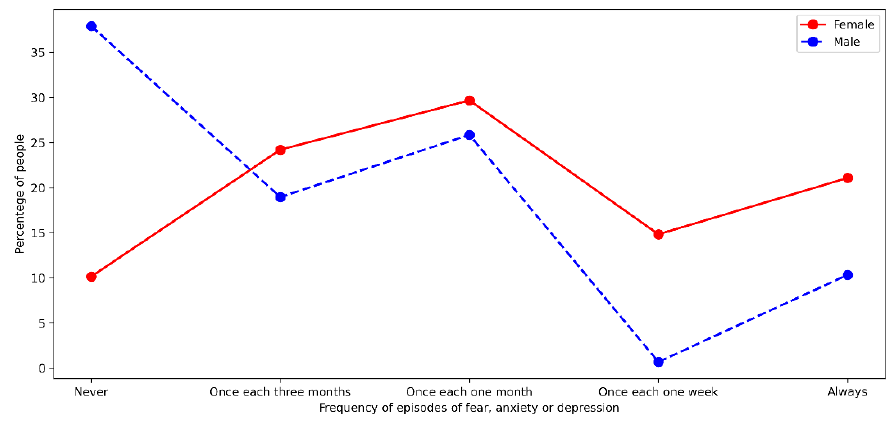
Figure 7. Mental health during pandemic.